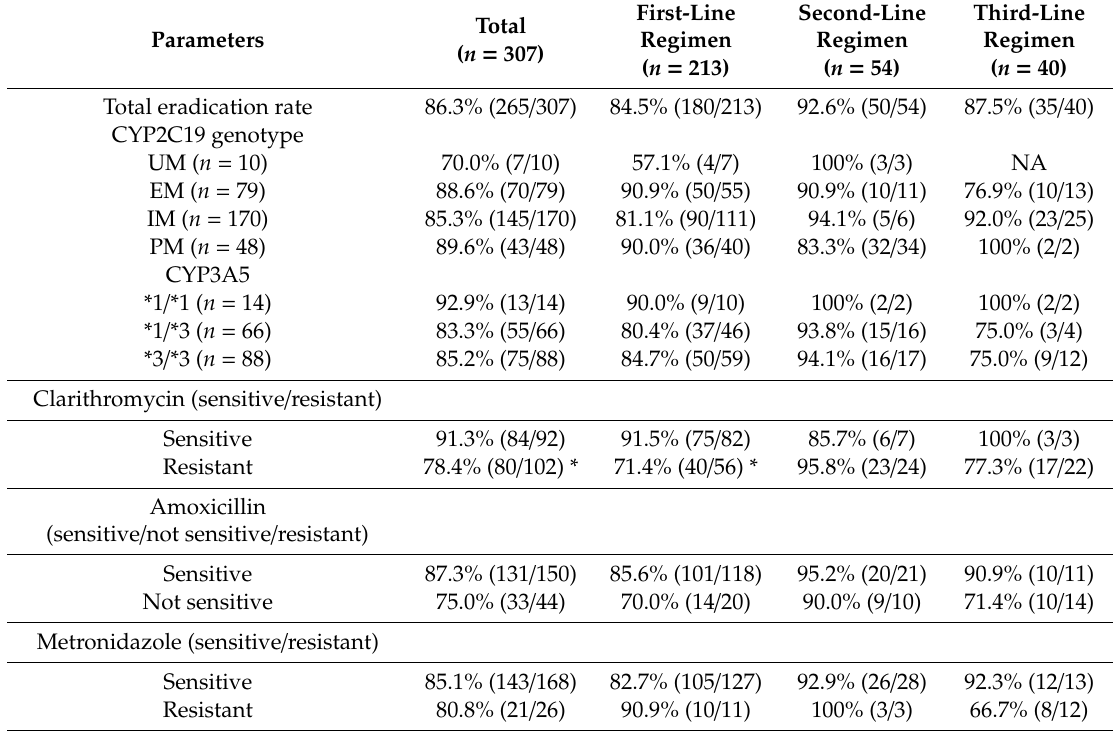
Table 2. Eradication rates in the first-line, second-line and third-line